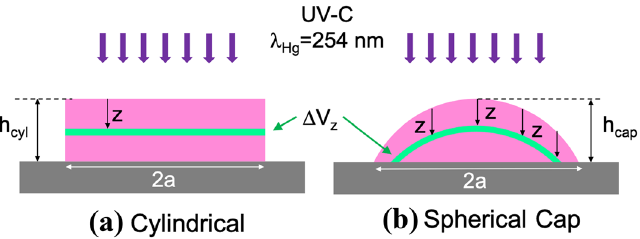
Figure 2. Geometry of the virus culture for two cases: cylindrical ( a ) and spherical cap ( b ). The diameter of the sample is given by 2 a and its height h cyl and h cap for the cylinder and the spherical cap,